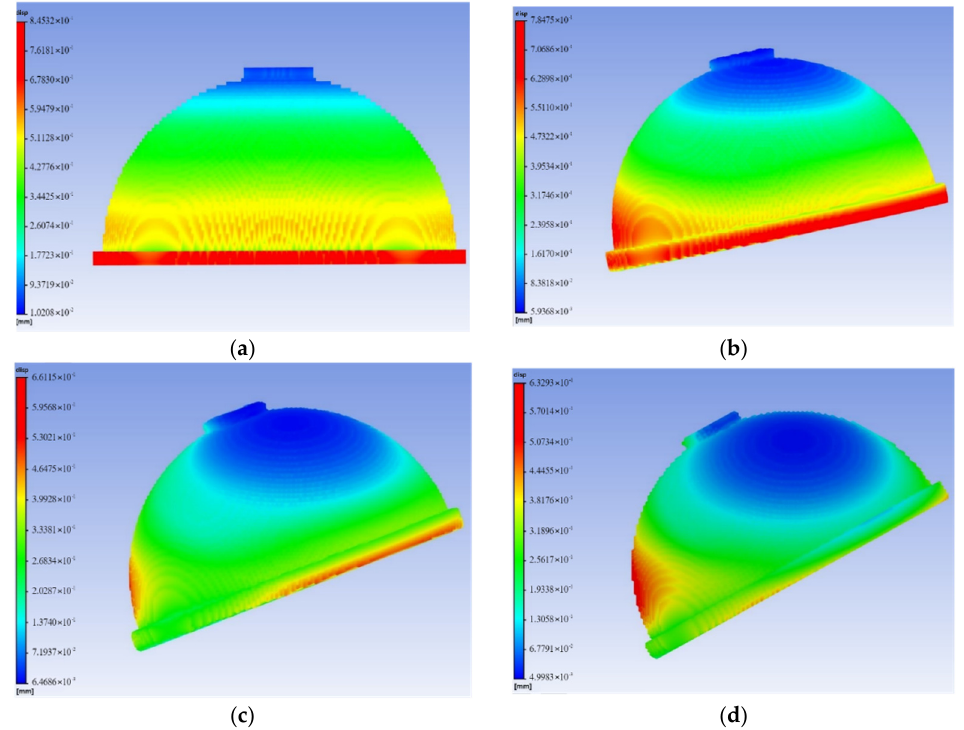
Figure 13. Schematic diagram of different forming angles of the acetabular cup: ( a ) 0°; ( b ) 15°; ( c ) 30°; ( d ) 45°.